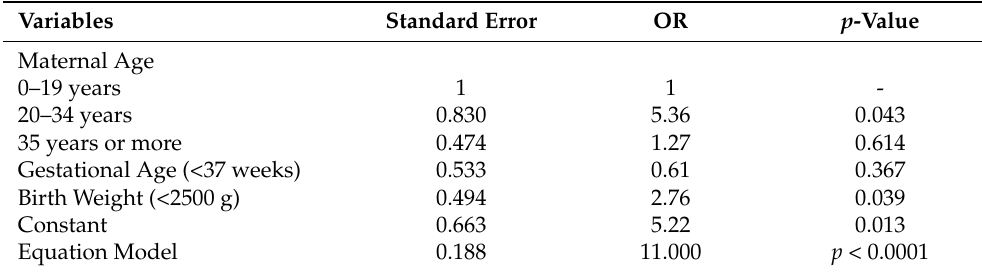
Table 2. Logistic regression for variables associated with number of prenatal visits (<4